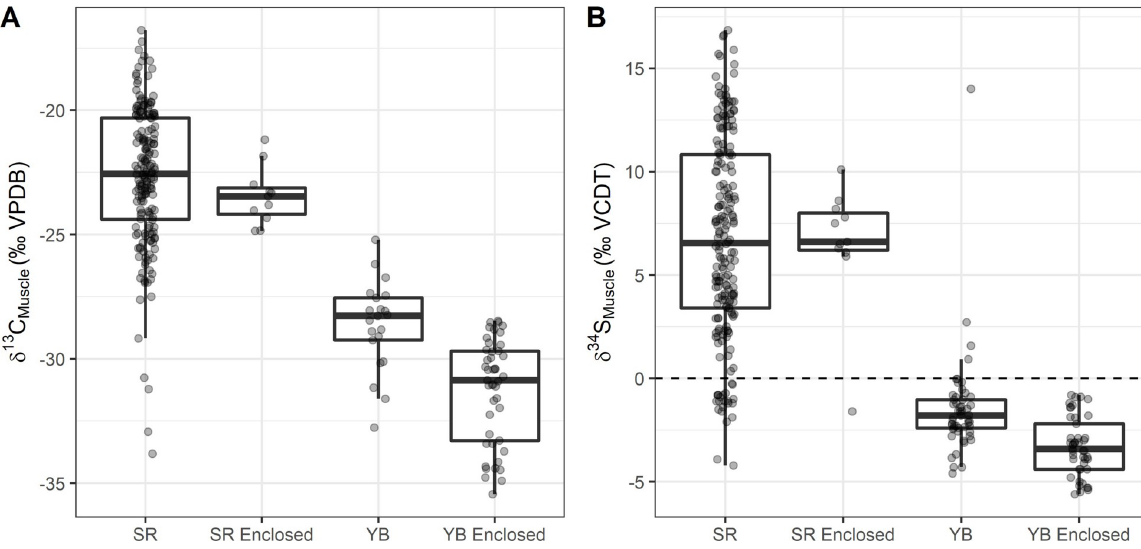
Fig 6. δ 13 C and δ 34 S values in muscle tissues for wild-caught and enclosed (experimental fields and cages) fish in the river and floodplain habitats averaged for all years sampled. Only muscle tissue data from enclosed fish reared more than 24 days of the time series were used to show the final isotope values assimilated into